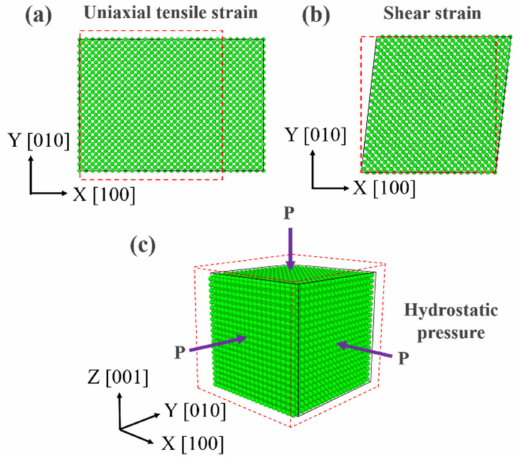
Figure 2. Schematic maps of ( a ) uniaxial tension, ( b ) shear deformation, and ( c ) hydrostatic compres- sion of the cubic single-crystal